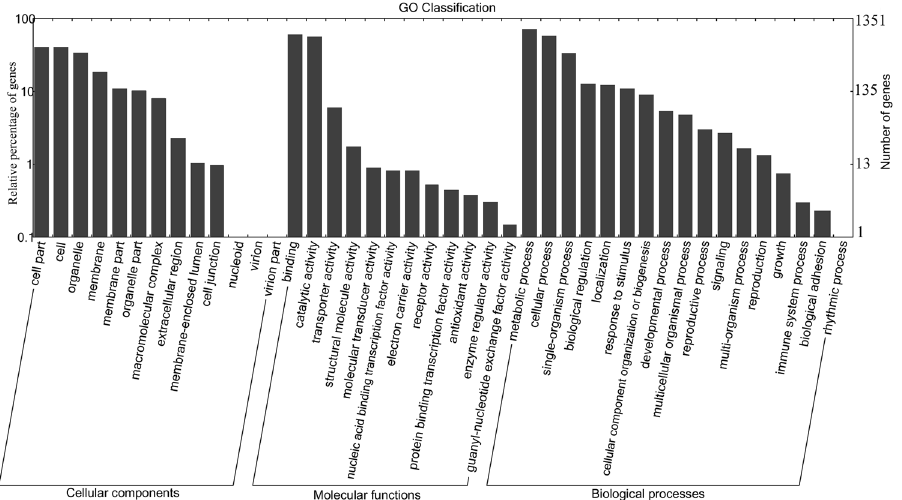
Figure 6. Gene Ontology (GO) analysis of WRKY target genes in D. officinale . Categories pertaining to cellular components, molecular functions and biological processes were defined by GO